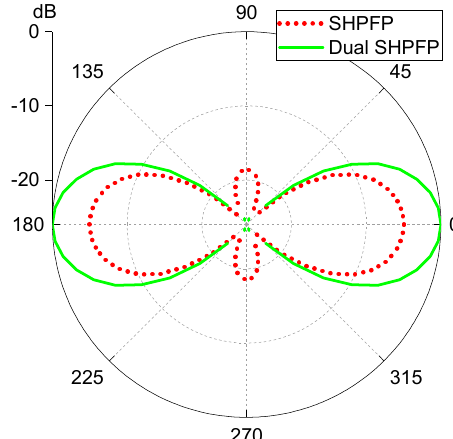
Figure 15. A comparison of the SH0 wave directivity of the SHPFP (the red dotted line) versus the dual SHPFP (the green solid line) at a center frequency of 80 kHz. The values were normalized to the maximum value of the dual SHPFP transducer.